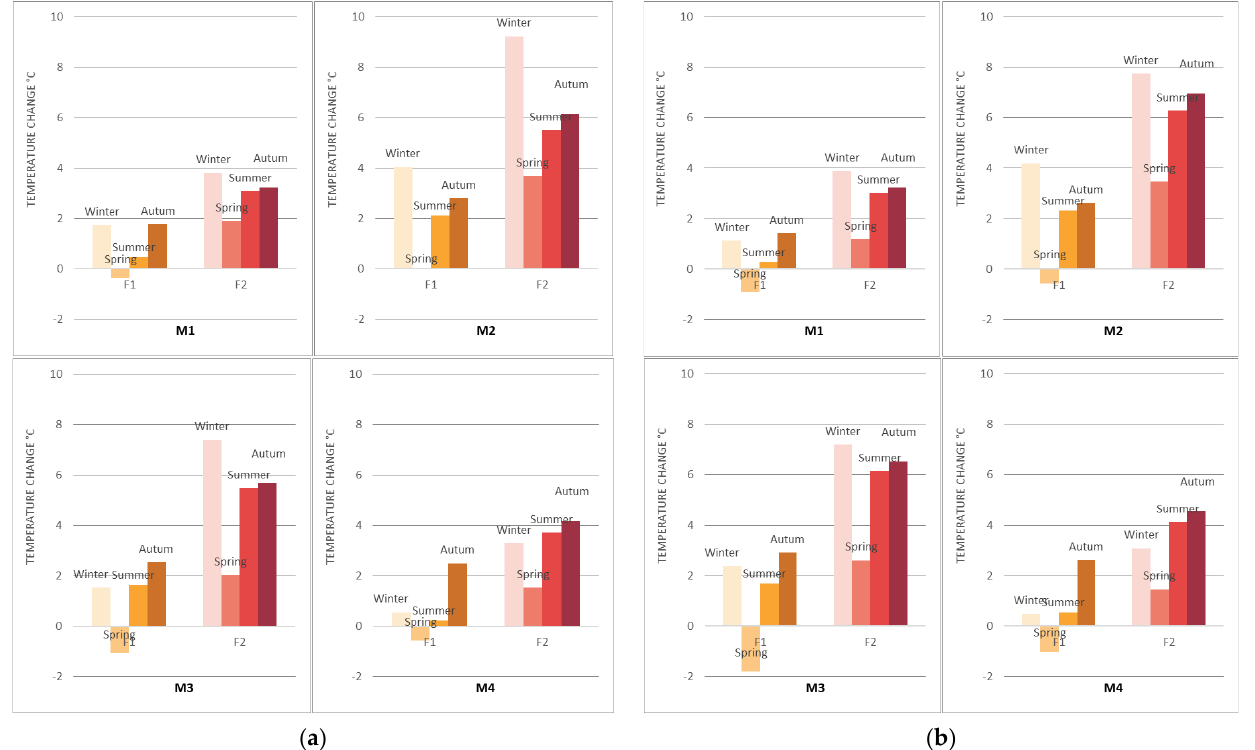
Figure 7. The changes of the hourly average temperature of seasons in Climate zone I ( a ) and II ( b ). Bars with yellow-toned colour are hourly average temperature increases at F1 compared with present scenario. Bars with red-tone colour are hourly average temperature increases at F2 compared with present scenario.